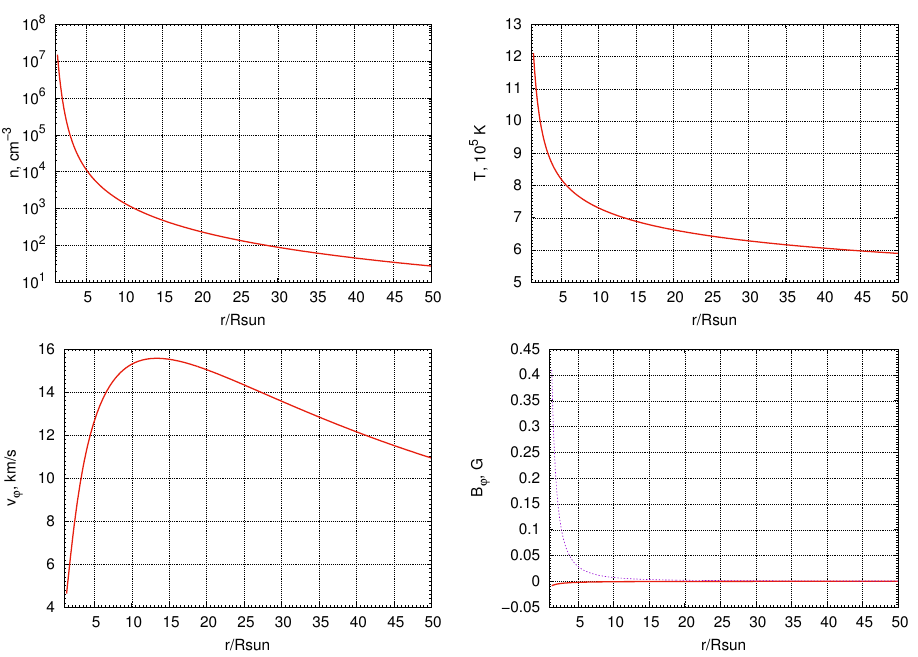
Figure 4. Particle number density profiles n ( r ) ( top left ), temperature profiles T ( r ) ( top right ), azimuthal velocity v ϕ ( r ) ( bottom left ), as well as the radial B r ( r ) (dotted line) and azimuthal B ϕ ( r ) (solid line) components of the magnetic field ( bottom right